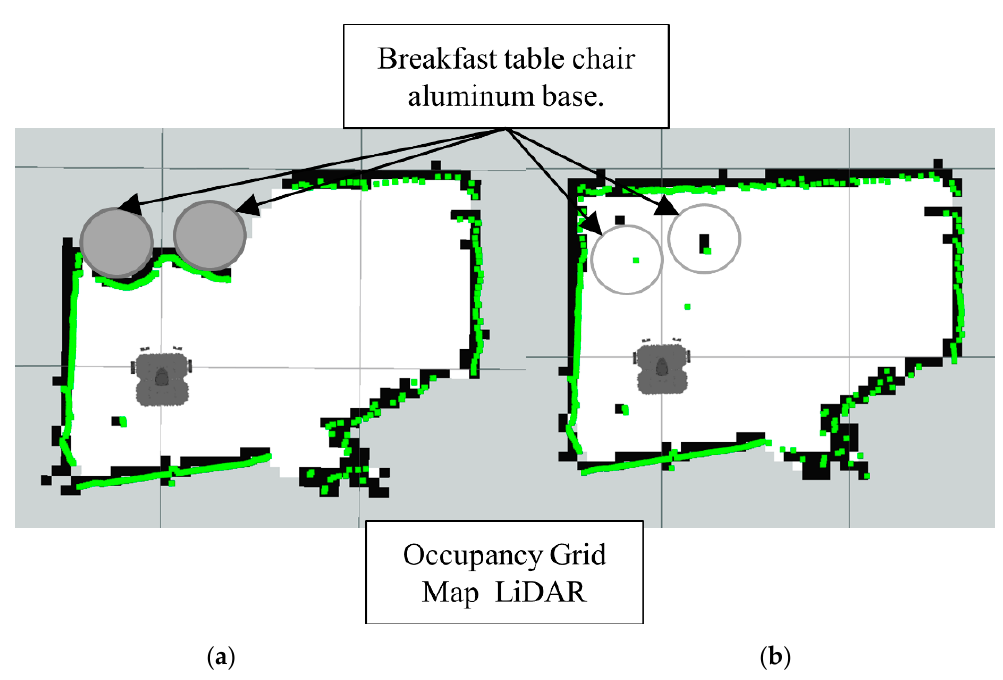
Figure 19. Occupancy grid maps showing the: ( a ) Ground truth (reference map); ( b ) LiDAR gener- ated map.